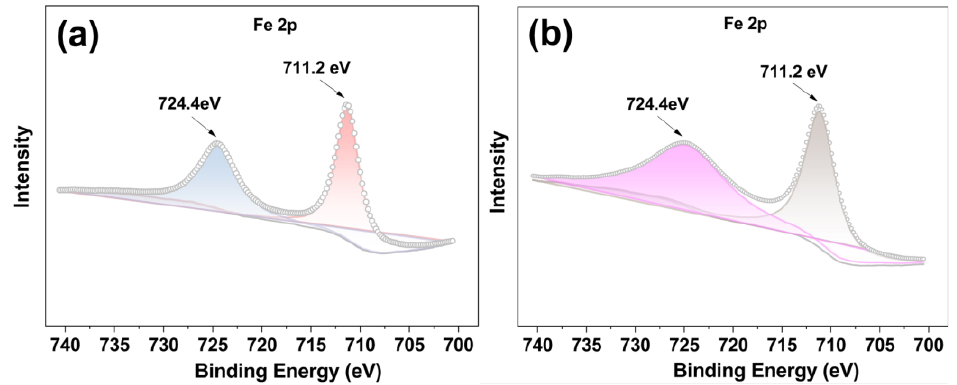
Figure 3. The Fe 2p XPS spectra of Fe II -THPP ( a ) and [Fe II -THPP-NPs] ( b ), showing binding energies at 711.2 eV (Fe 2p 3/2 ) and 724.4 eV (Fe 2p 1/2 ) ( a , b ), thus supporting the identical structures of Fe II - THPP and [Fe II -THPP-NPs].